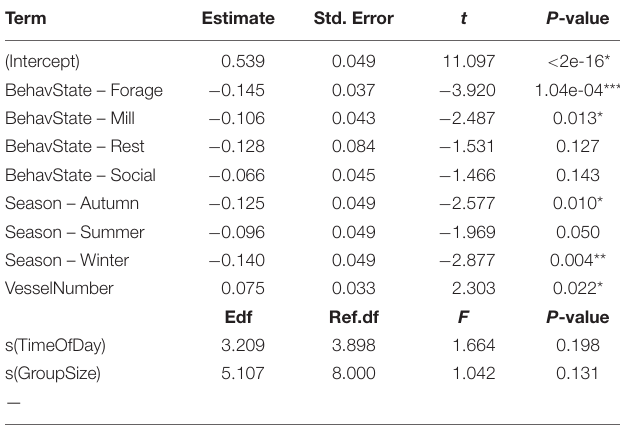
TABLE 5 | Summary of output for best fitting model for Indo-Pacific humpback dolphin swimming speed. Term Estimate Std.